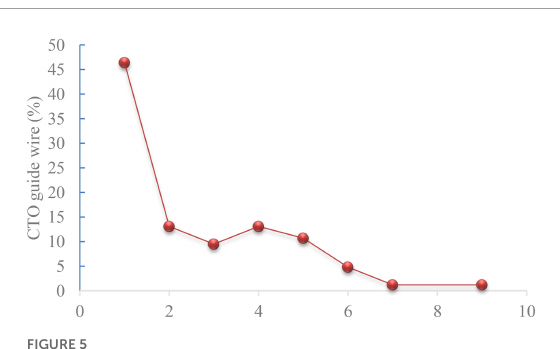
FIGURE5 Chronic total occlusion (CTO) guide wire usage analysis ( n =